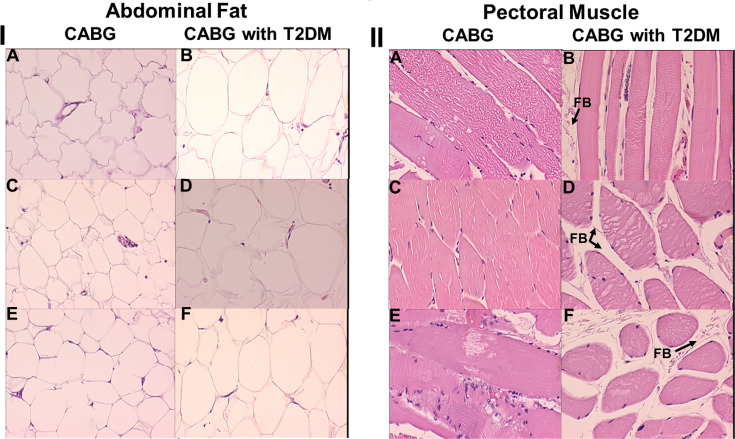
H & E histology of abdominal fat (I) and pectoral muscle (II) from patients with and without T2DM undergoing CABG procedure.The noted feature in panel II is fat build-up (FB). 20x magnification.